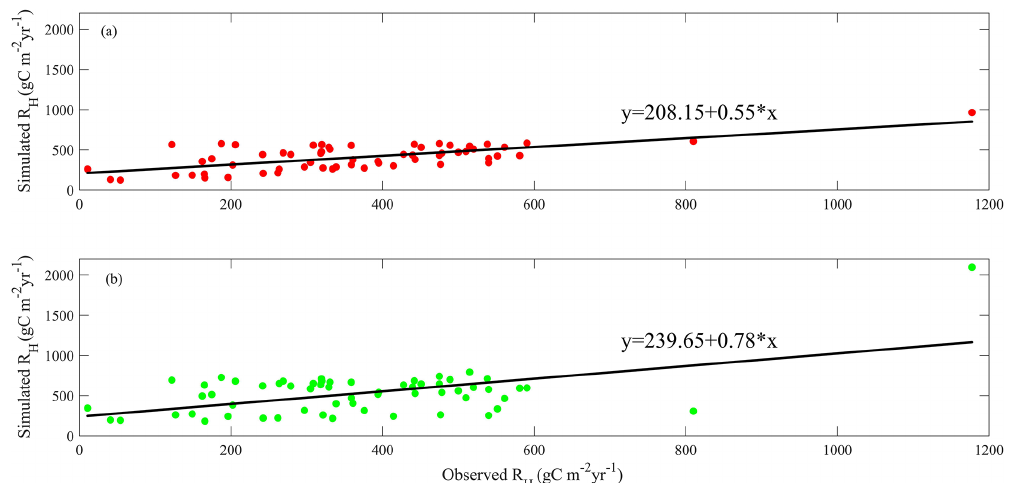
Figure 6. Linear regression between simulated and observed annual R H (gCm − 2 yr − 1 ) for (a) MIC-TEM-dormancy and (b) MIC-TEM.